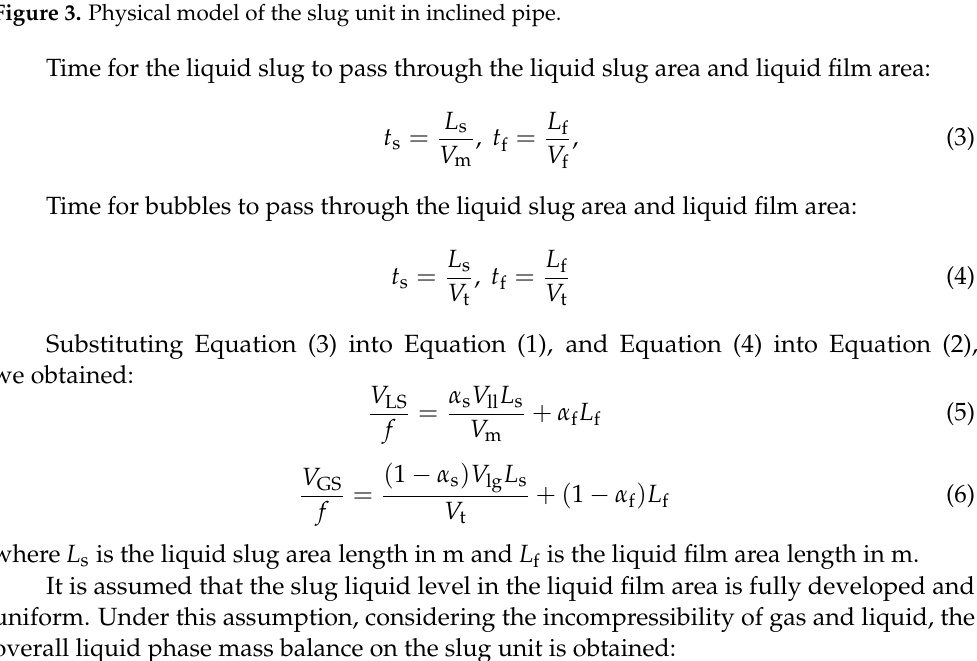
Figure 3. Physical model of the slug unit in inclined pipe.